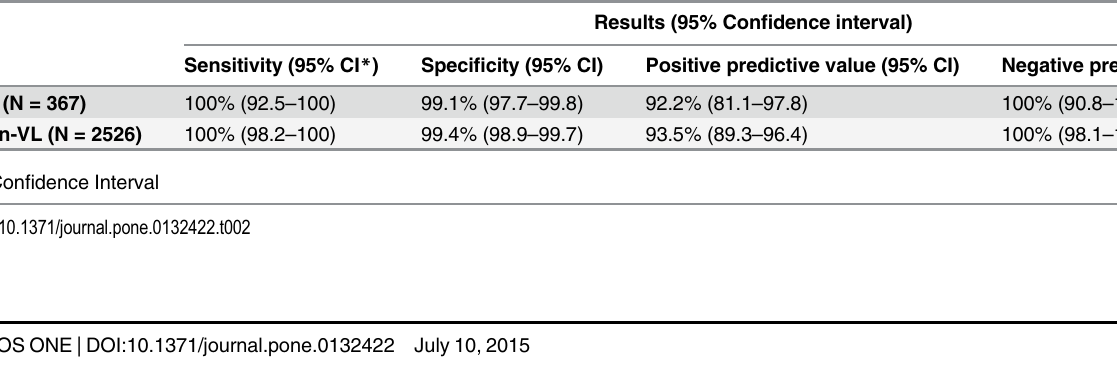
Table 2. Algorithm performance characteristics by visceral leishmaniasis (VL)